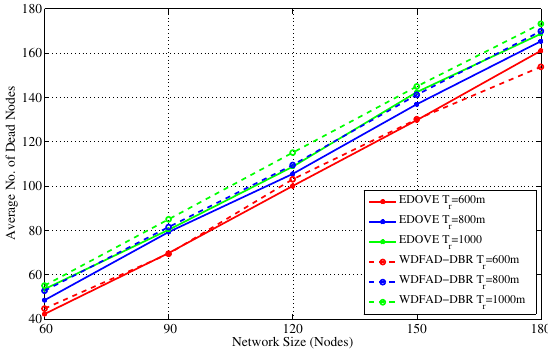
Figure 14. Number of dead nodes versus different network sizes.